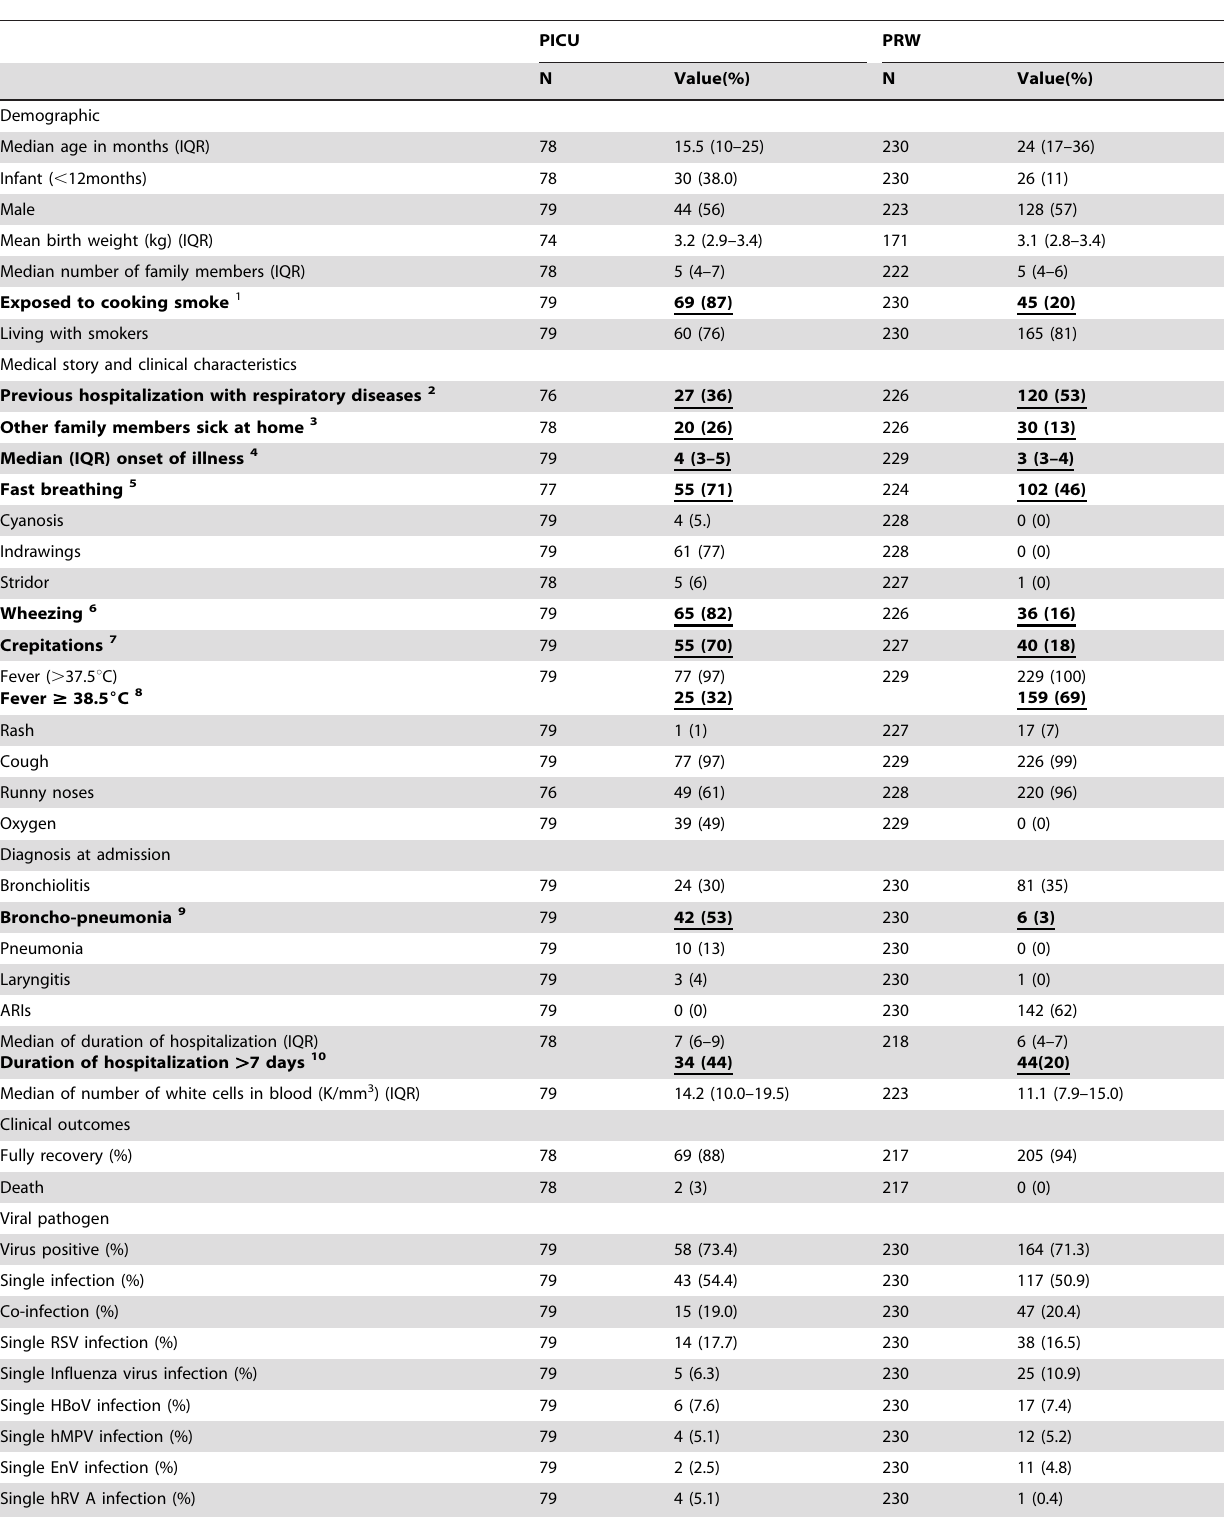
Table 2. Demographic and clinical characteristics of study